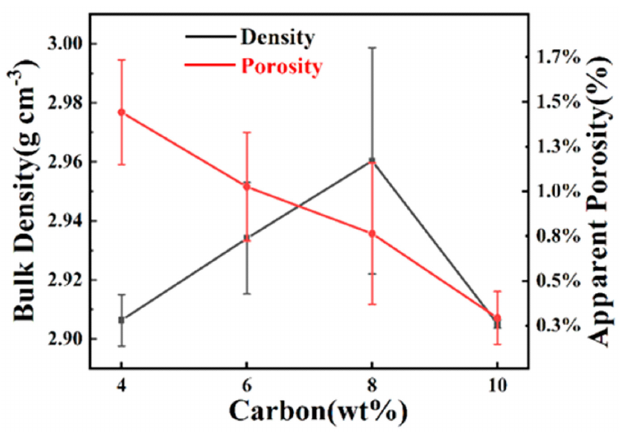
Figure 12. Bulk density and porosity of RBSCs with different carbon